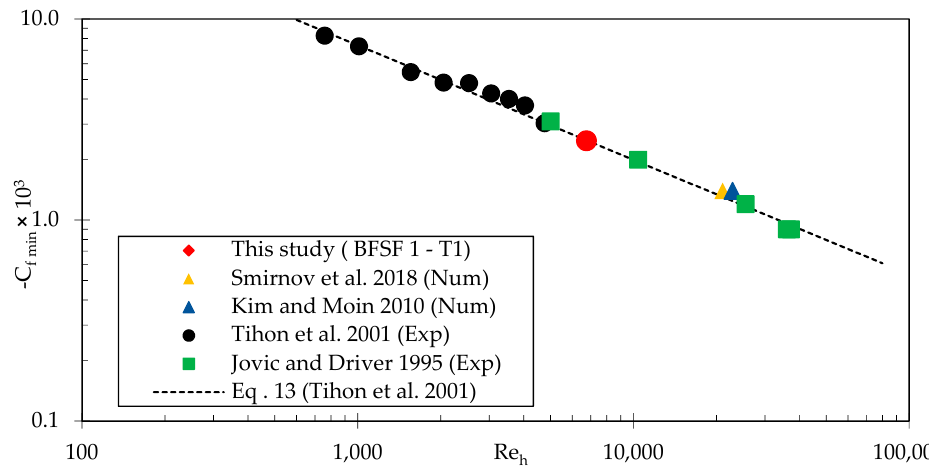
Figure 12. Dimensionless minimum peak of the skin friction coefficient (C f, min ) vs. (Re h ), [15,16,26,37].